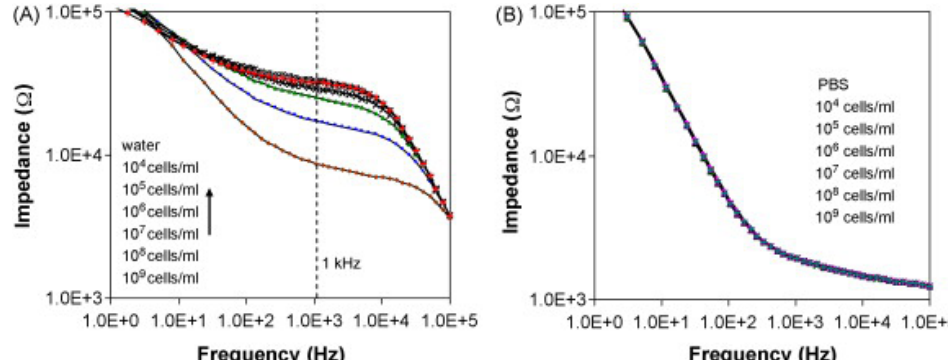
Figure 3. Impedance spectra of Salmonella suspensions in ( A ) DI water and ( B ) PBS with the cell concentrations in the range of 10 4 to 10 9 cfu/mL, along with water and PBS as controls. Frequency range: 1 Hz–100 kHz. Amplitude: ±50 mV. (Copyright 2008. Reprinted from [27] with permission from